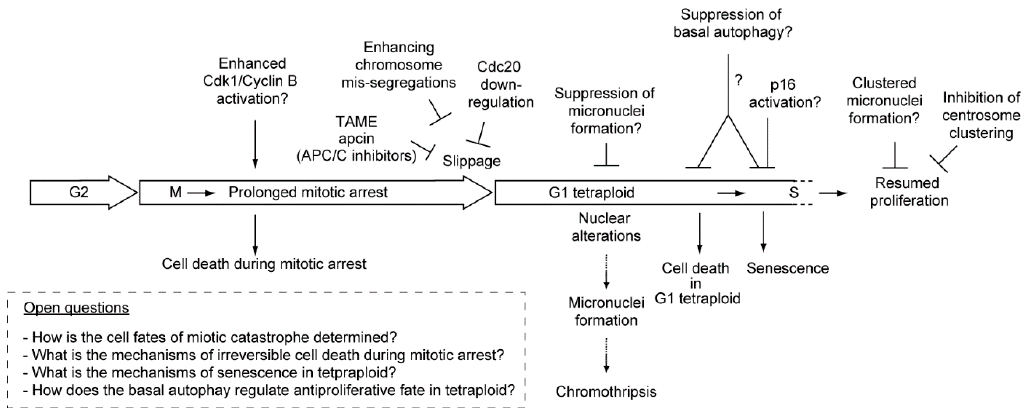
Figure 5. Potential strategies to improve the efficacy of microtubule poisons in cancer therapy (for details, see the text).